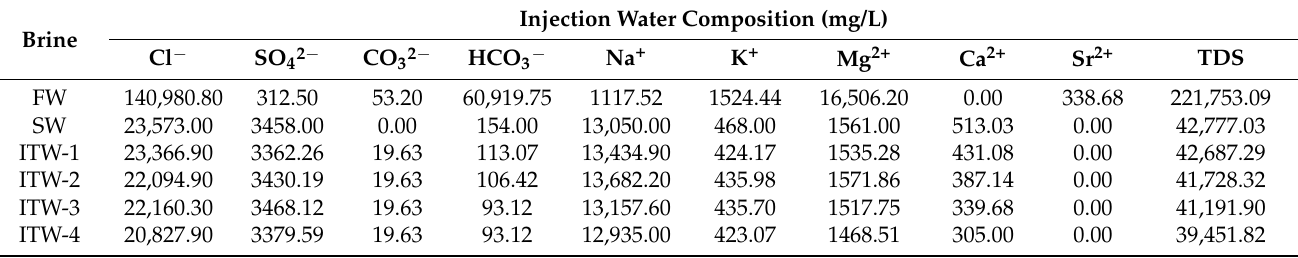
Table 1. Specifications of the brines used in this study.